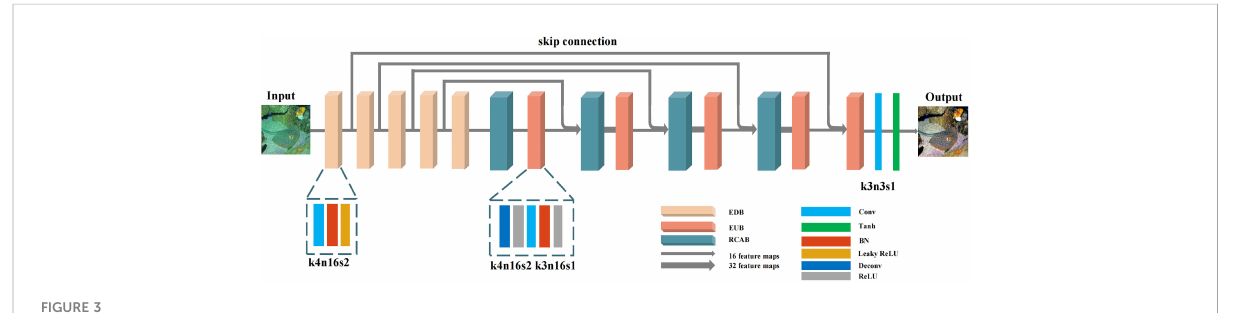
FIGURE 3 The architecture of the